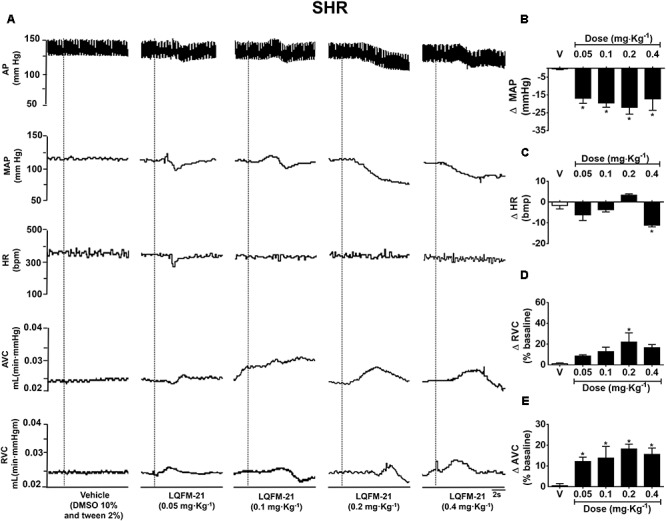
(A) Typical tracing of changes in cardiovascular parameters induced by intravenous injection of vehicle or LQFM-21 in anaesthetized SHR. Dashed line indicates the vehicle or LQFM-21 infusion. (B) Mean arterial pressure (MAP), (C) Heart rate (HR), (D) renal vascular conductance (RVC), (E) aortic vascular conductance (AVC) in anaesthetized SHR from the response to infusions of vehicle (∙) and LQFM-21 (∙) at doses 0.05, 0.1, 0.2, 0.4 mg⋅kg-1. Data are expressed as mean ± SEM, with their standard errors represented by vertical bars (n = 6). ∗Values significantly different from treated with vehicle; p < 0.05.